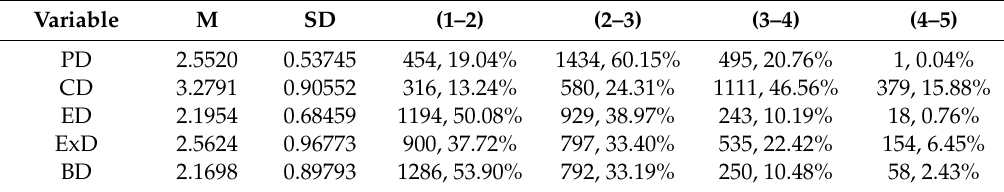
Table 2. Descriptive statistical analysis of psychological distance ( N =